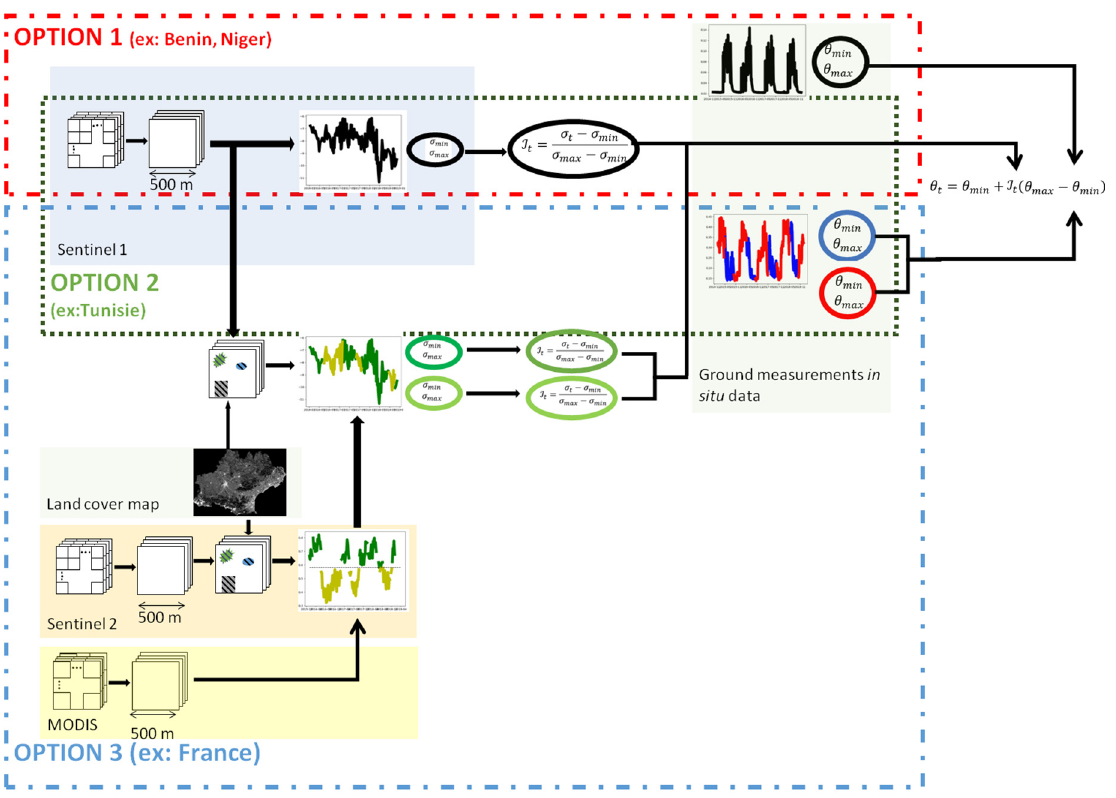
Figure 6. General scheme of the Soil Moisture Estimations from the Synergy of Sentinel-1 and optical sensors (SMES) algorithm.